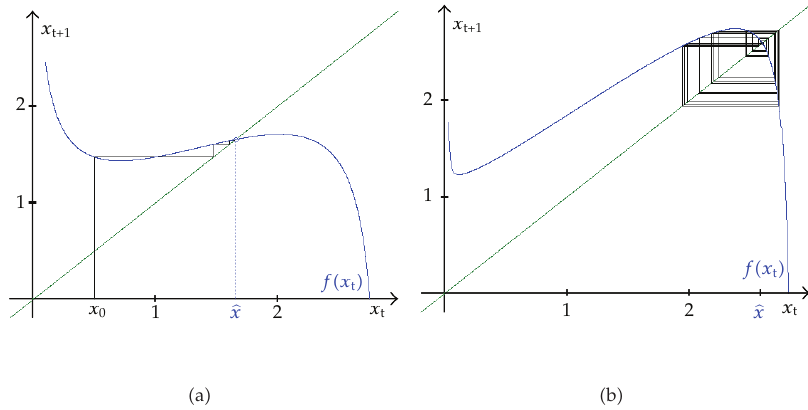
Figure 2: (cid:2) a (cid:3) Obtained with this set of parameters: m (cid:8) 4 ,p (cid:8) 1 . 4 ,γ (cid:8) 0 . 9, and α (cid:8) 0 . 58, we have that